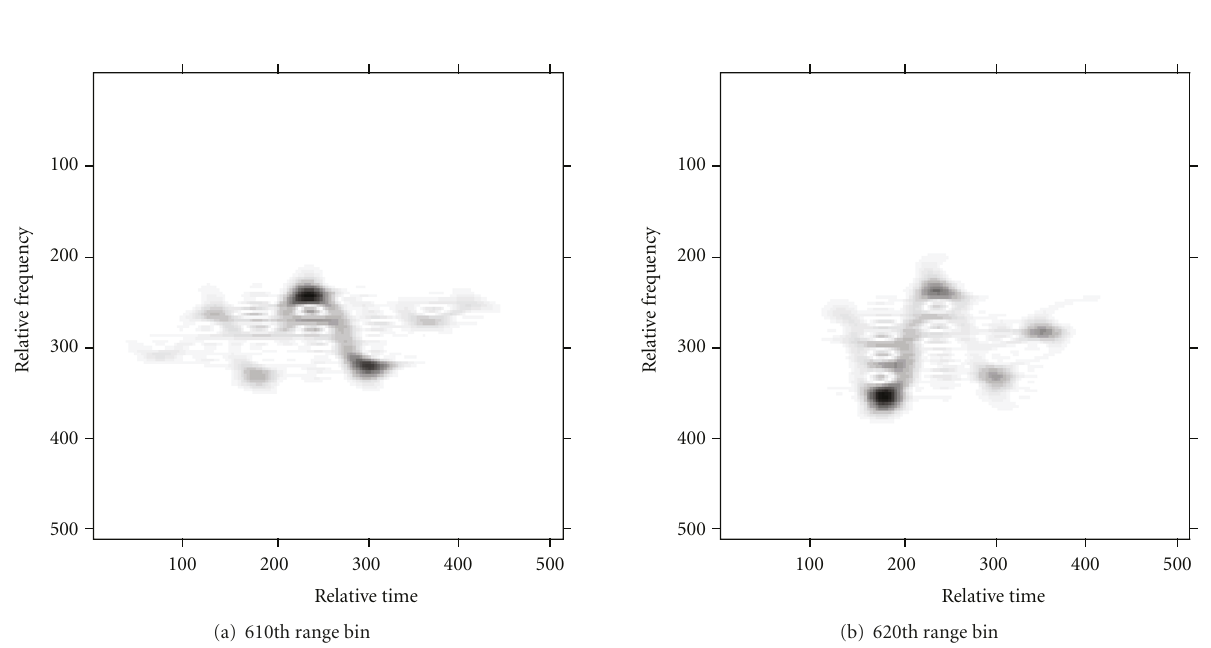
Figure 9: SPWVD of the received signal in a range bin.